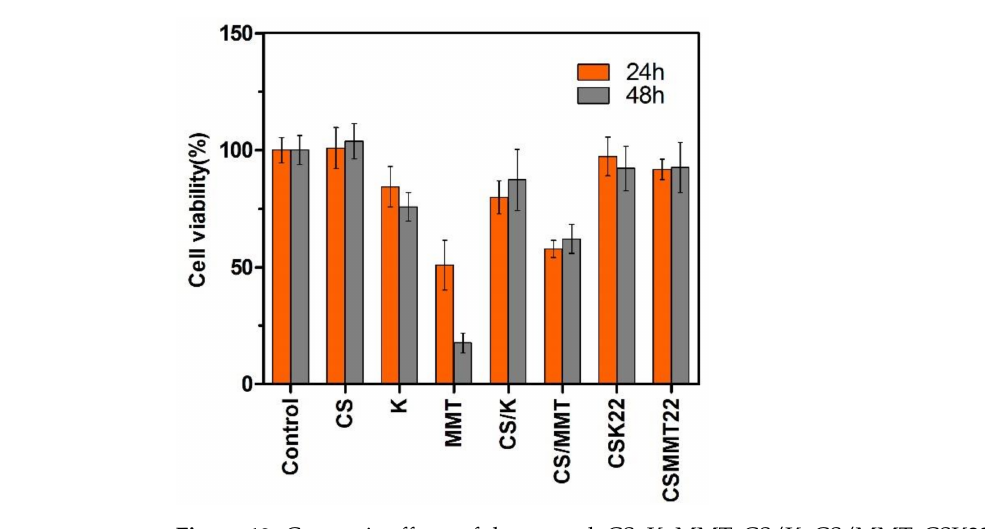
Figure 10. Cytotoxic effects of the control, CS, K, MMT, CS/K, CS/MMT, CSK22, and CSMMT22. Data represent the mean ± SD ( n = 6).